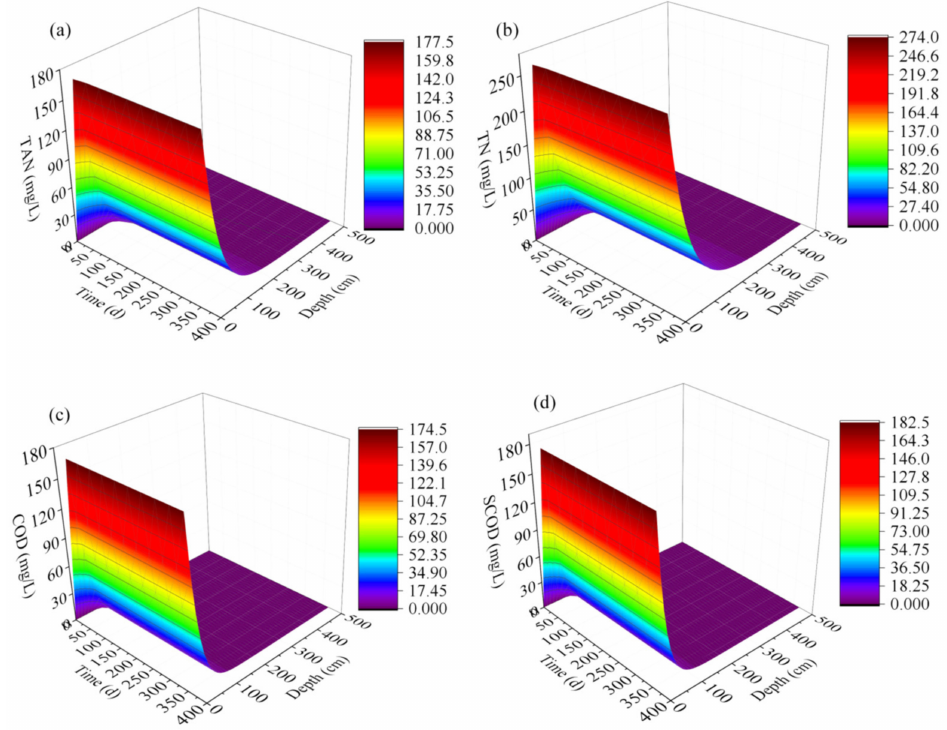
Figure 9. Predicted values of ( a ) TAN, ( b ) TN, ( c ) COD and ( d ) SCOD transport in soil. Note: TAN— Total ammonia nitrogen; TN—Total nitrogen; COD—Chemical oxygen demand; SCOD—Soluble chemical oxygen